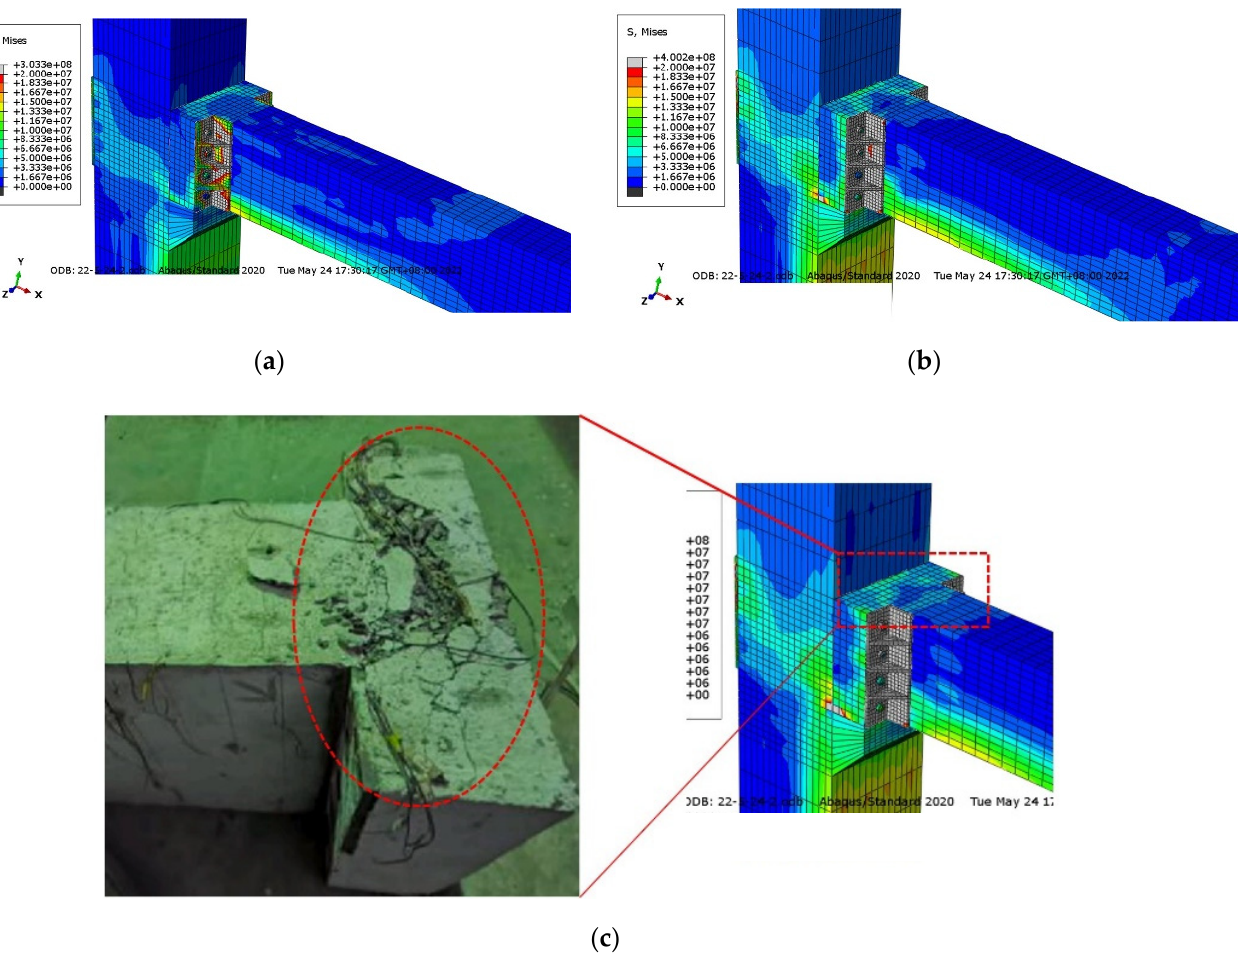
Figure 26. Stress cloud of specimen J2: ( a ) +20 mm stage stress cloud; ( b ) +50 mm stage stress cloud; ( c ) +70 mm stage stress cloud.